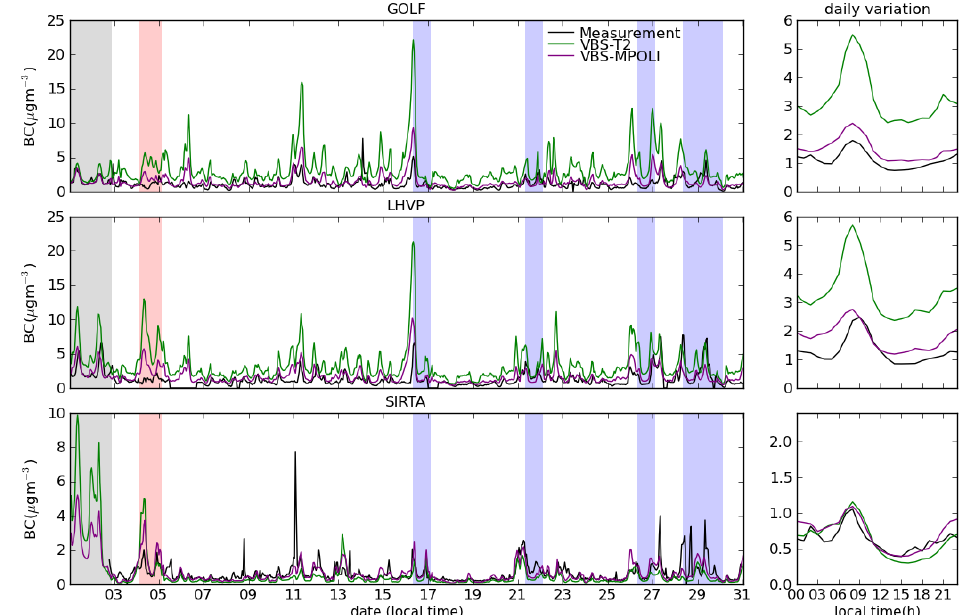
Fig. 3. Comparison of simulated and observed NO x at GOLF, LHVP and SIRTA. On the left side, time series; on the right side, hourly averages for July 2009.